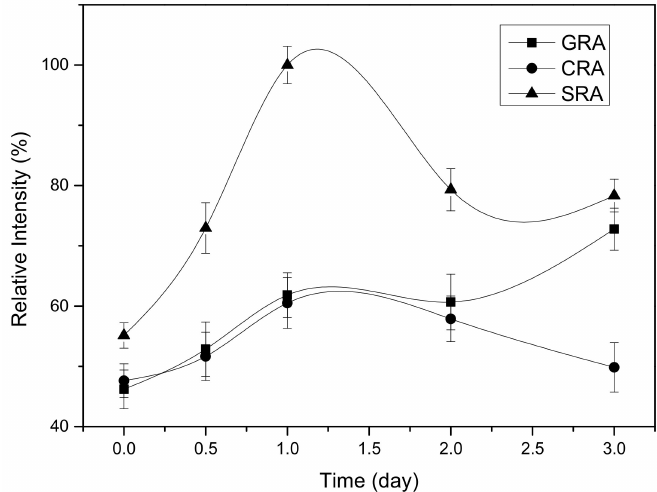
Figure 2. Time profiles of the intein cleavage reactions for three OCVs, where the relative color intensity of the cleaved part was used to represent the protein